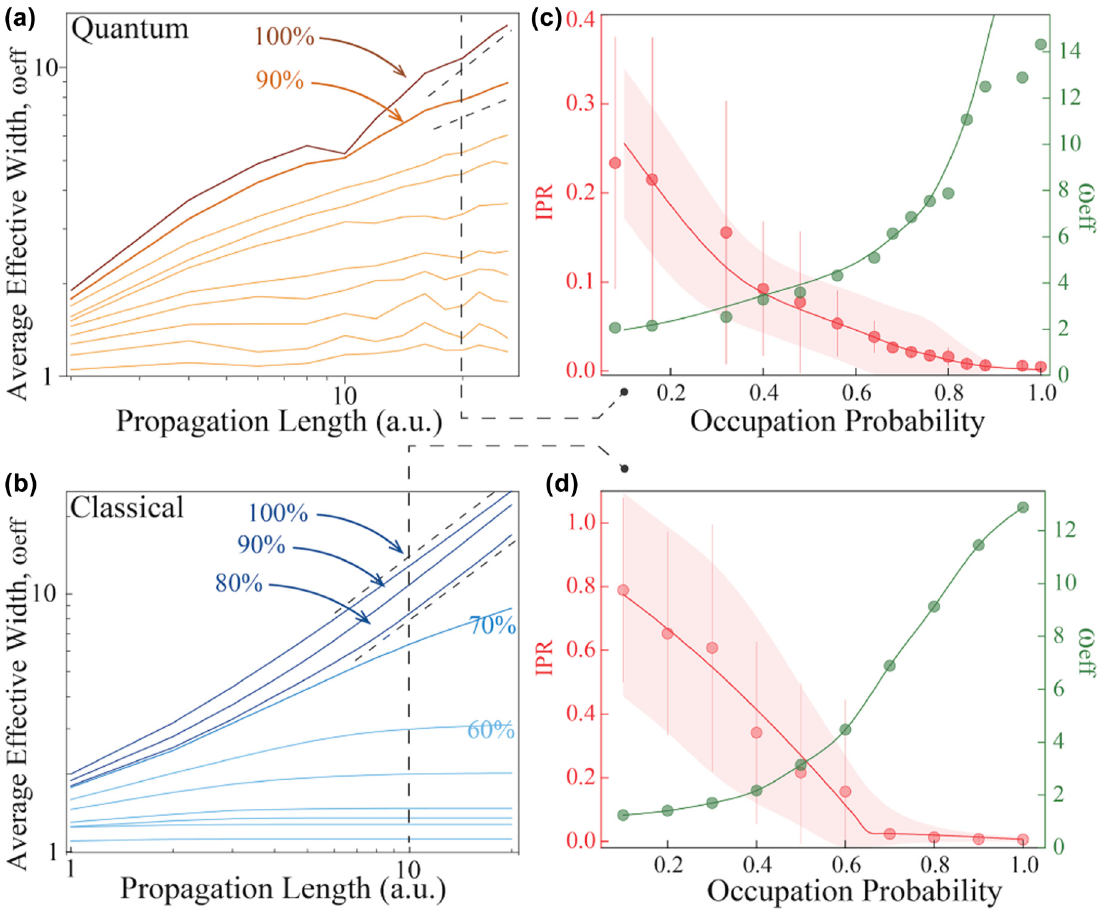
Figure 3: Evolution features in quantum and classical percolation. (a–b) Time evolution of average effective width. (a) Different curves show a ballistic and a diffusive transport respectively. It is localized when 0 < 𝜈 < 1 represent different P values and the slope 𝜈 = 1 ,𝜈 = 1 2 (b) The slope remains at 1 when P > 80 % and drops rapidly under 70 % , showing a great accordance with the predicted threshold at 69.62 % and also with 63 % in our model. In the propagation length of 20 mm, we retrieve the different distributions of inverse participation ratio (IPR) in the (c) quantum and (d) classical percolation. All the points in (c) are experimental data, which are extracted from and effective widths 𝜔 eff the transverse spatial patterns captured after photons evolve over 20 mm in percolation lattices. All the points in (d) are from theoretical